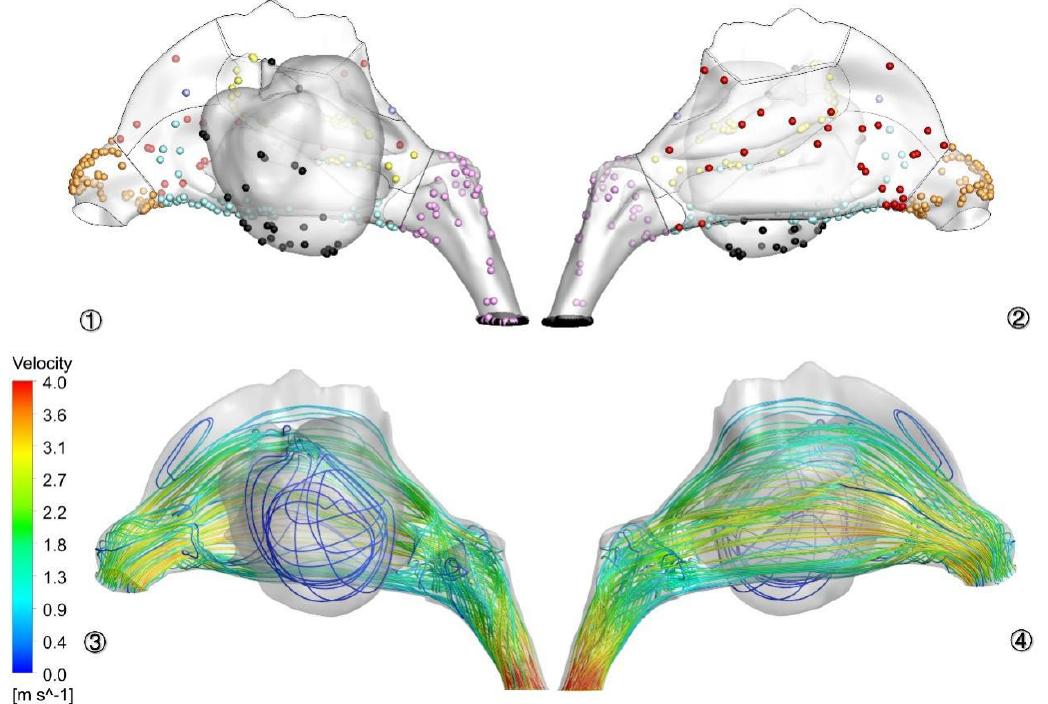
Figure 5. Under a 30 L/min inspiratory condition, ① and ② show the deposition diagram of A. niger spores on nasal cavity surface ( ① left view, ② right view); ③ and ④ show the particle trajectories of A. niger spores moving with airflow ( ③ left view, ④ right view).